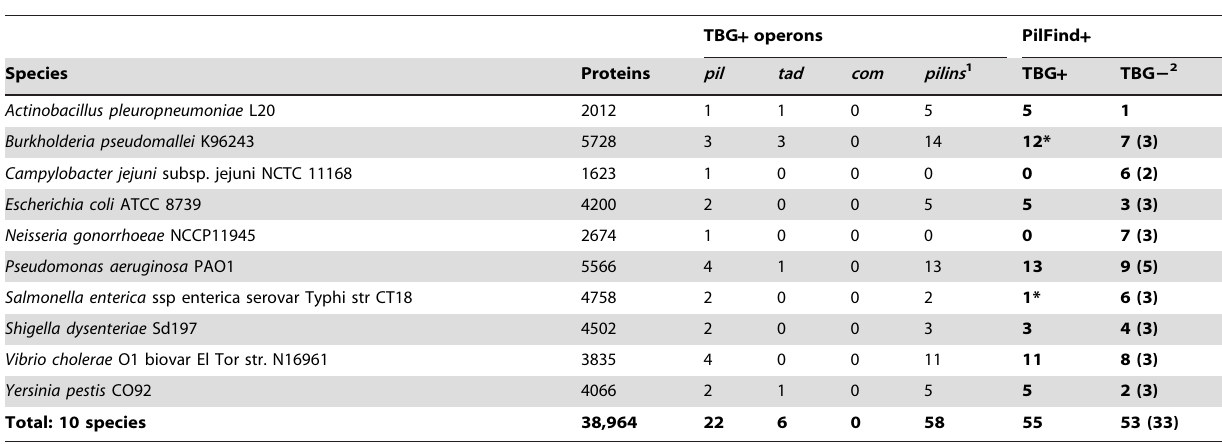
Table 5. Gram-negative type IV pilins identified by